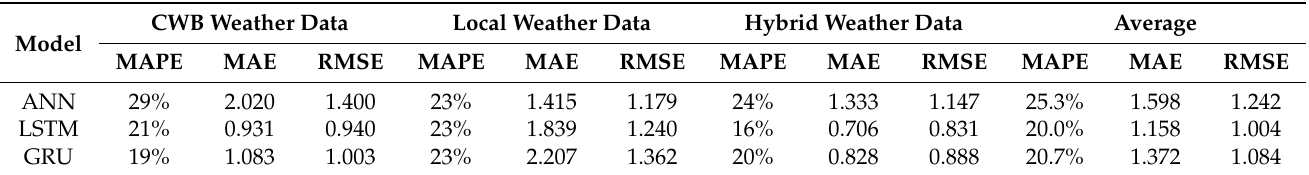
Table 8. Average one-day-ahead PV power forecasting results of each weather data group for one week.